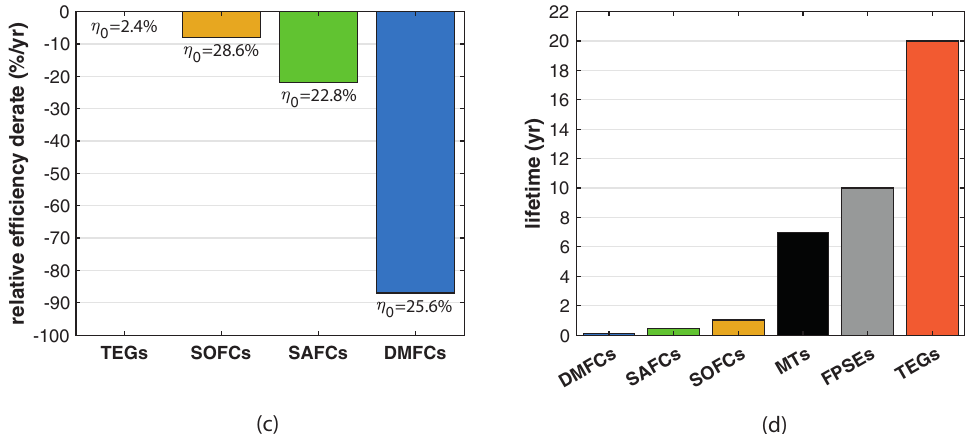
Figure 11. Comparison of the technical features: ( a ) power intervals, ( b ) available technologies and mean efficiencies for selected power classes (n.a.: not available), ( c ) relative efficiency derates and ( d ) lifetimes.